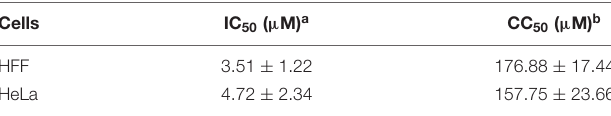
TABLE 1 | Inhibitory effect of resveratrol on VACV replication and